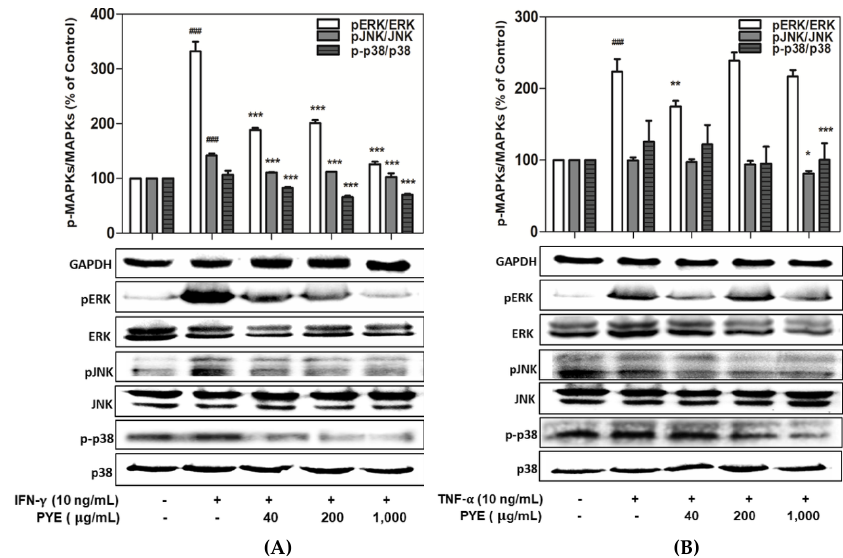
Figure 4. Effect of PYE on the mitogen-activated protein kinase (MAPK) signaling pathway in HaCaT cells. Protein was isolated from cells treated with IFN-γ (A) or TNF-α (B) in the absence or presence of varying concentrations of PYE for 24 h. Phosphorylation levels of extracellular signal-related kinase (ERK), c-Jun N-terminal kinase (JNK), and p38 determined using Western blot analysis. Equal amounts of protein loading were checked using total protein and housekeeping protein GAPDH antibodies. Relative levels of p-ERK, p-JNK, and p-p38 were calculated using Image Lab. Values are means ± standard deviation (SD) of independent experiments. Note: ### p < 0.001 control group vs. the IFN-γ or TNF-α (10 ng/mL)-treated group, and * p < 0.05, ** p < 0.01, and *** p < 0.001 IFN-γ or TNF-α (10 ng/mL)-treated group vs. PYE co-treated group.